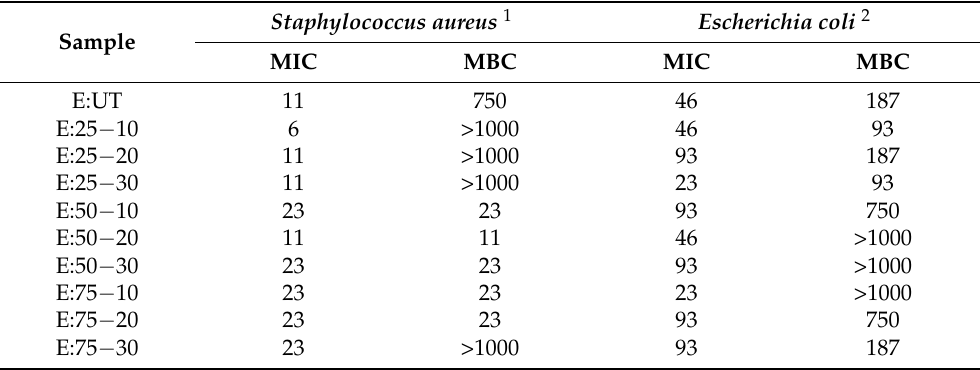
Table 3. Determination of the Minimum Inhibitory Concentration (MIC) and the Minimum Bacterici- dal Concentration (MBC) ( µ g · mL − 1 ) of the Brazilian red propolis extracts obtained under different conditions. Staphylococcus aureus 1 Escherichia coli 2 Sample MIC MBC